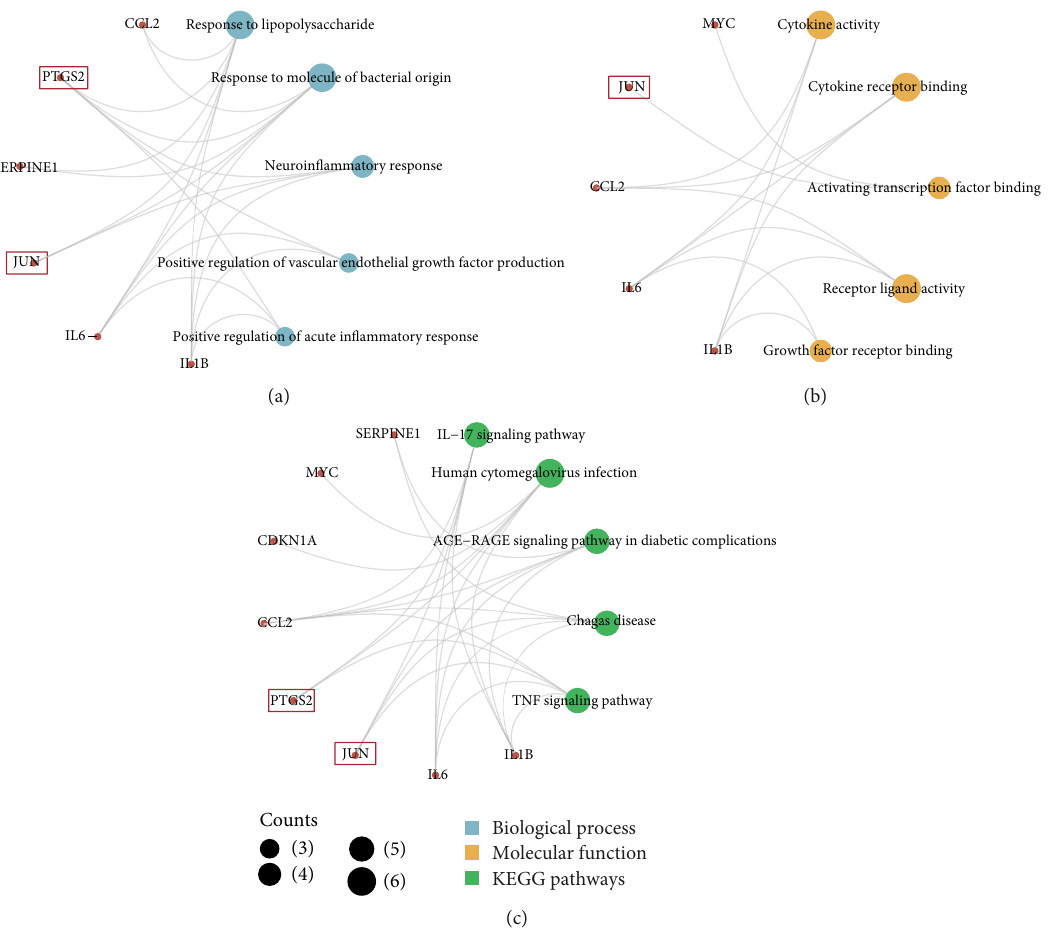
Figure 6: “ Enrichment analysis ” network. (a) The subnetwork of biological processes. (b) The subnetwork of molecular functions. (c) The subnetwork of KEGG pathways. The red nodes represent the targets gene of SQP, the blue nodes represent biological processes associated with these genes, the yellow nodes represent molecular functions associated with these genes, and the green nodes represent the KEGG pathways associated with these genes.